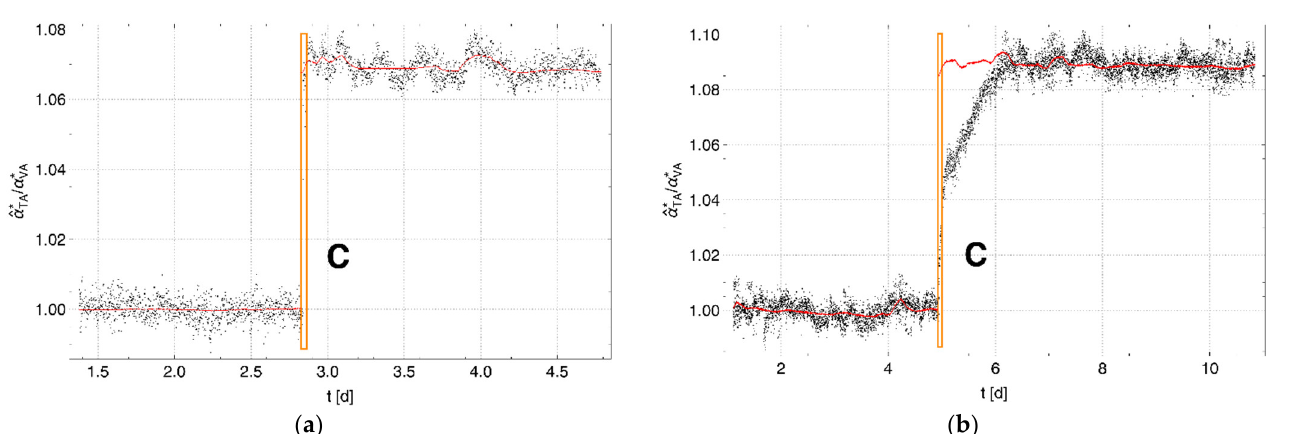
Figure 7. Ratio ˆ α ∗ / α ∗ (black) for the adjusted cells ( a ) for Experiment 1 and ( b ) for Experiment 3. TA VA Solid lines (red) represent the respective ratio from the calculated data. The region of data within the orange box marked C indicates the change of the saturated vapor in the test container to a liquid water environment in the surroundings of the membrane tube, while the tube in the vapor container is always surrounded by vapor-saturated air. Unlike in Experiment 1, the membrane tube within the test container was placed in a body of sand in Experiment 3 and surrounded by cotton fabric. While the calculated results (red) for both experiments show a sudden jump at point C, the measurements followed the calculated values only in Experiment 1. The significant deviation in Experiment 3 must be due to (vapor-saturated) air partly covering the membrane surface after watering at